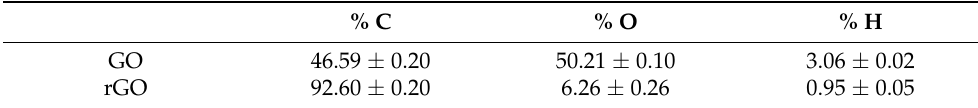
Table 1. Elemental analysis (average % and standard deviation of carbon, oxygen, and hydrogen) for GO and rGO